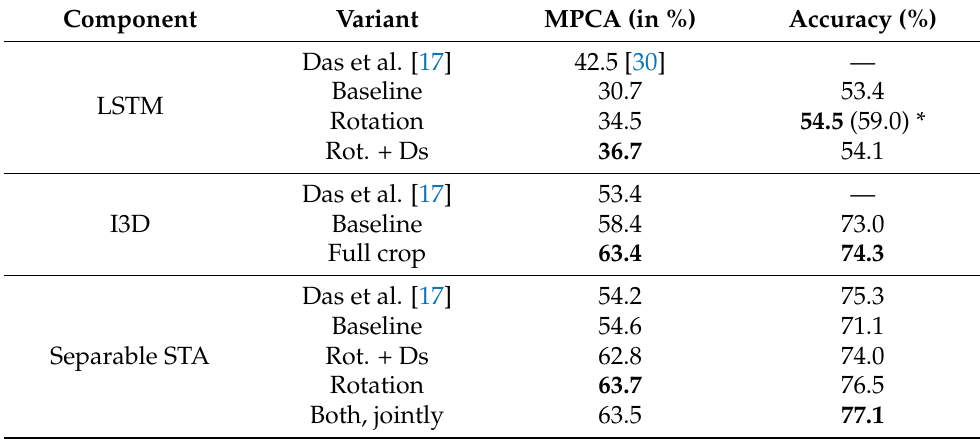
Table 1. Results for the cross-subject evaluation (CS). ‘Both’ refers to rotation with no distances and full crop (jointly-trained, i.e., leaving I3D branch layers as trainable). Results provided in mean per-class accuracy (MPCA) and overall classification accuracy. Best result in